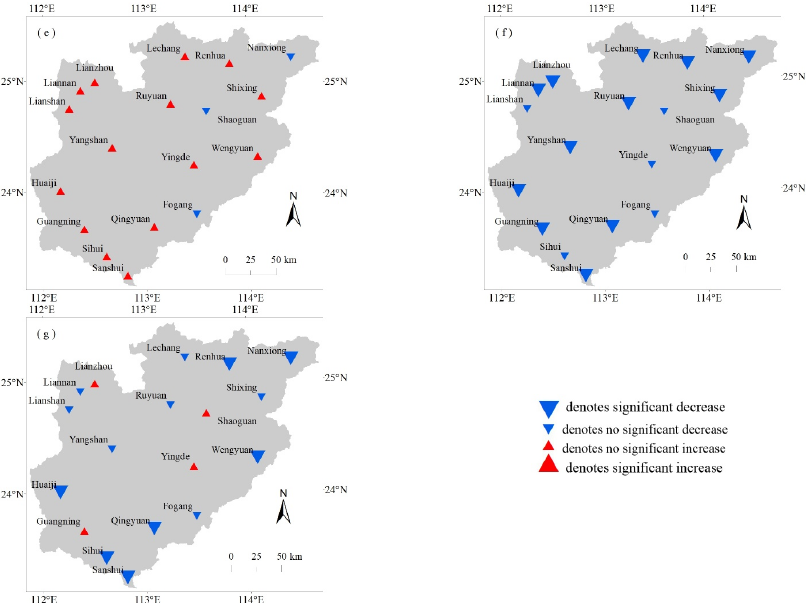
Figure 4. Spatial distribution of change trend of PRCPTOT ( a ), SDII ( b ), Rx1day ( c ), Rx5day ( d ), CDD ( e ), CWD ( f ), and R95ds ( g ) in Beijiang River Basin from 1959 to 2018.